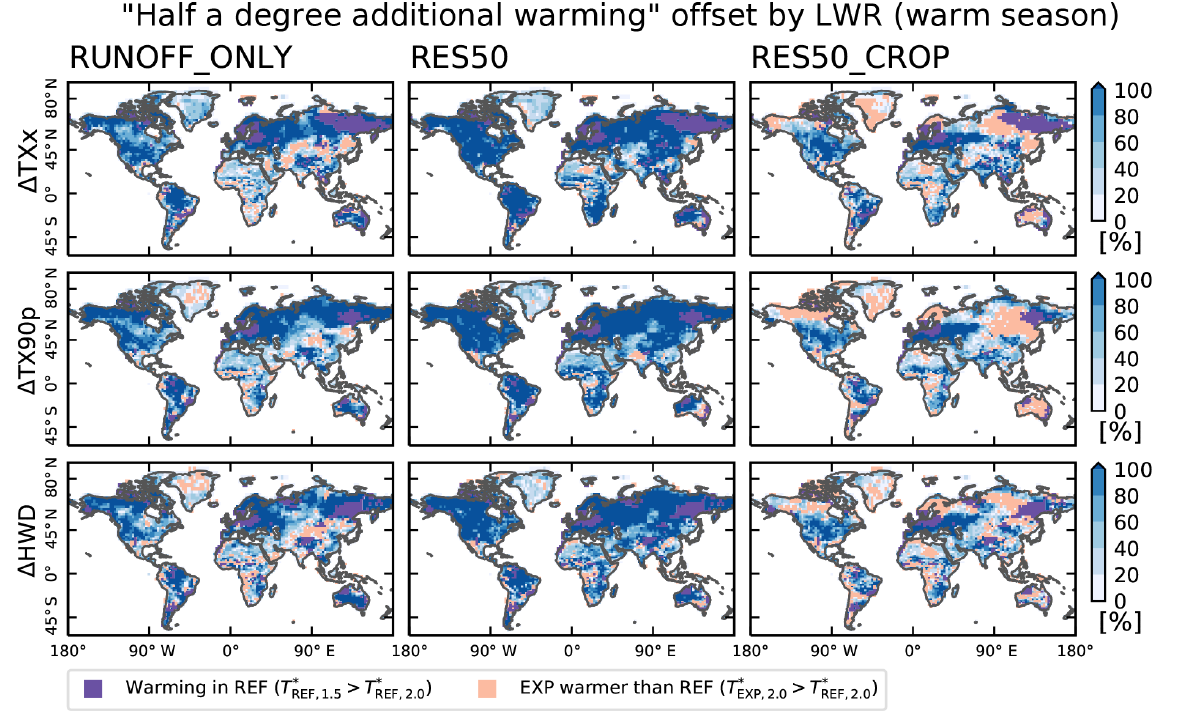
Figure 6. Offset of half a degree additional global mean warming by the LWR experiments, see Eq. (1). Light red indicates regions where the LWR experiments are warmer than REF (for 2.0 ◦ C global mean warming), magenta indicates regions where the 1.5 ◦ C climate is warmer than the 2.0 ◦ C climate in